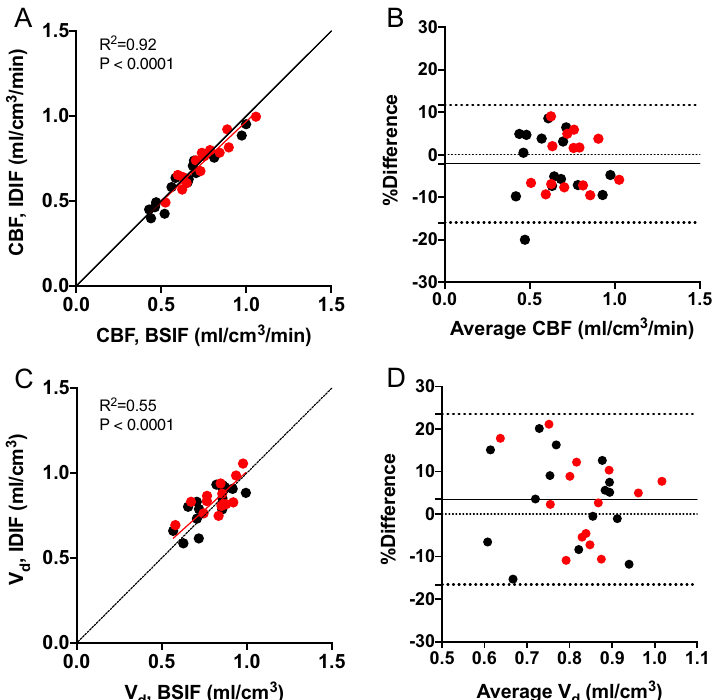
Fig. 6 Scatter plots comparing whole-brain GM CBF ( A ) and V d measurements ( C ) for BSIF and IDIF with baseline scans in black and post-acetazolamide scans in red. Bland–Altman plots are also shown for percentage differences for CBF ( B ) and V d ( D ) against the average. GM: grey matter. CBF cerebral blood flow. V